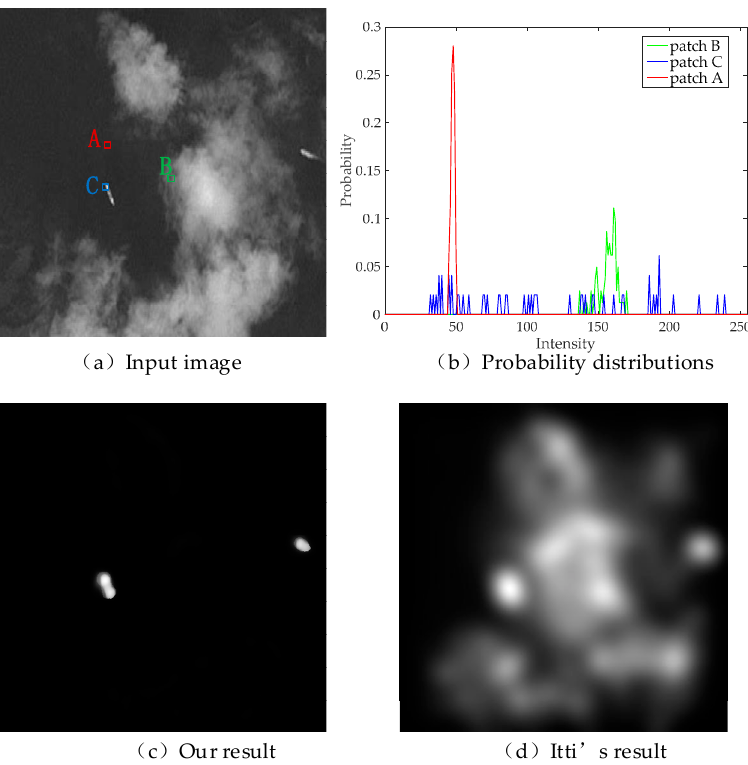
Figure 2. The proposed saliency model based on region variance analysis. ( a ) the original image; ( b ) probability distributions of patches A–C. The region variance values in terms of intensity information for A–C are 2.8, 87.6 and 1.8 × 10 3 , respectively, and the sizes of A–C are all 8 × 8 pixels. For contrast, our and Itti’s results are shown in ( c , d ), respectively.